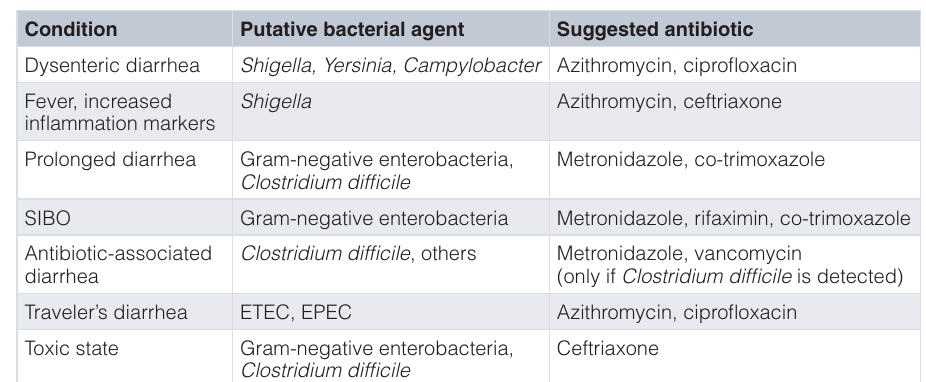
Table 1. Clinical conditions and circumstances that may indicate antibiotic